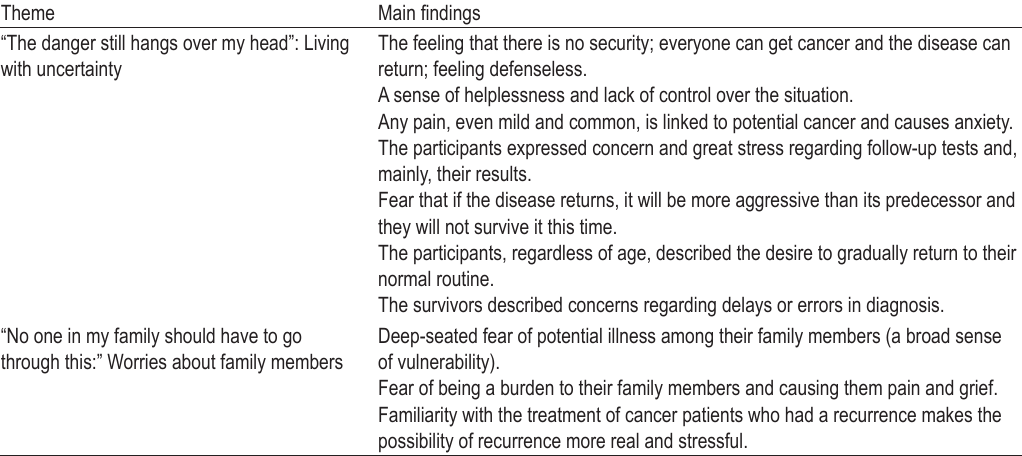
TABLE 2. Summary of the main findings Theme Main